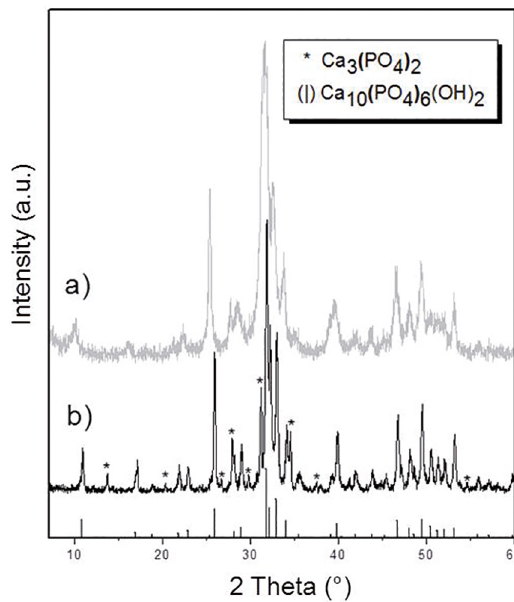
Figure 2: (a) Precipitate powder and (b) calcined powder XRD patterns.